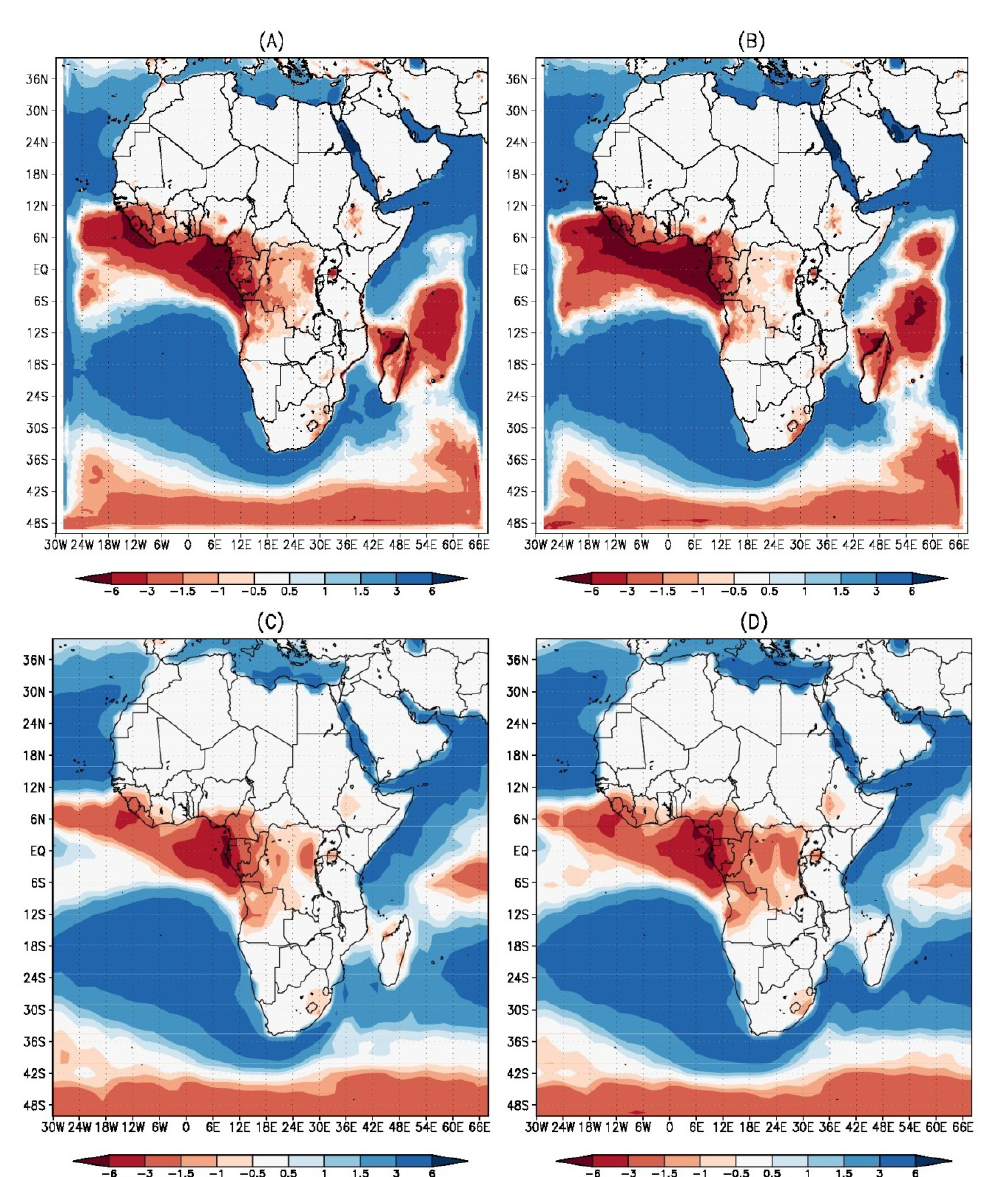
Figure 6. Simulated convergence (mm/day) ( A ) REMO 1971–1980; ( B ) REMO 2071–2080, and ( C ) MPI-ESM 1971–1980;( D ) MPI-ESM 2071–2080. Here